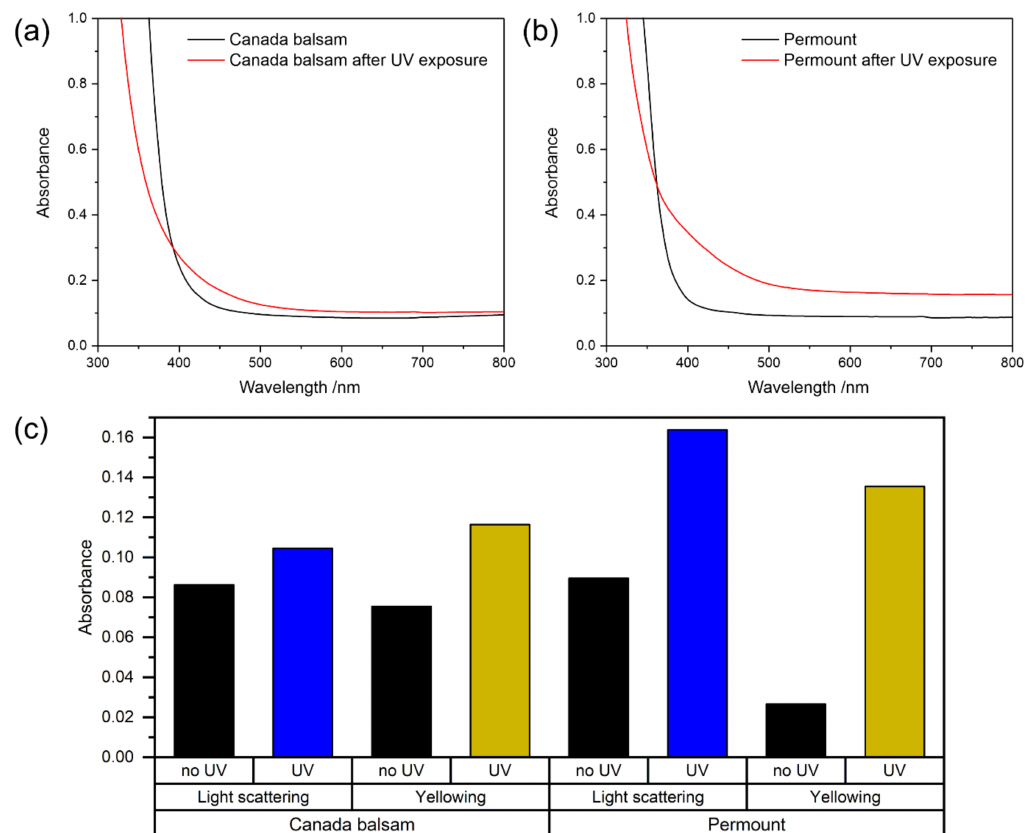
Figure 9. UV–Vis spectra of ( a ) Canada balsam and ( b ) Permount TM before and after exposure to UV radiation. In ( c ), measures for the extent of light scattering and yellowing derived from the spectra ( a , b ) are shown (see text for